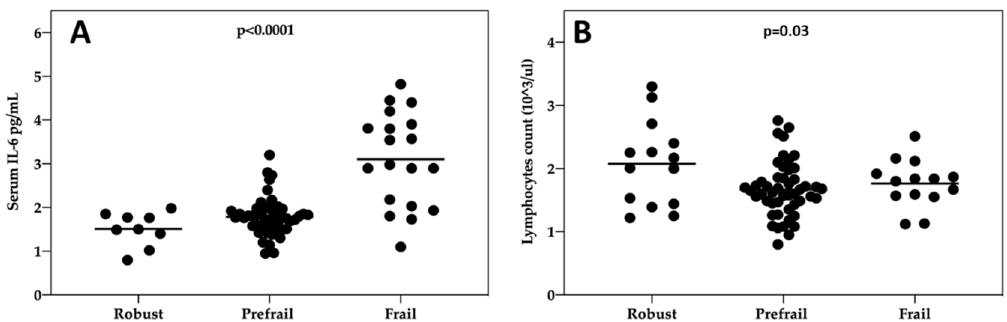
Figure 3. Evaluation of the relationship between frailty syndrome and IL-6 and lymphocytes count at baseline and follow-up pooled together. Frailty was measured according to the 5 criteria proposed by Fried et al. (2001) [15]. ( A ) IL-6 (pg / mL), ( B ) lymphocytes count (1 × 10 3 / mL) were measured in the blood, and plotted against the categories of frailty, which was expressed as follows: participants who met 3 or more criteria were classified as frail, those who met 1 or 2 were prefrail, and those who did not meet any of the criteria were nonfrail (robust).